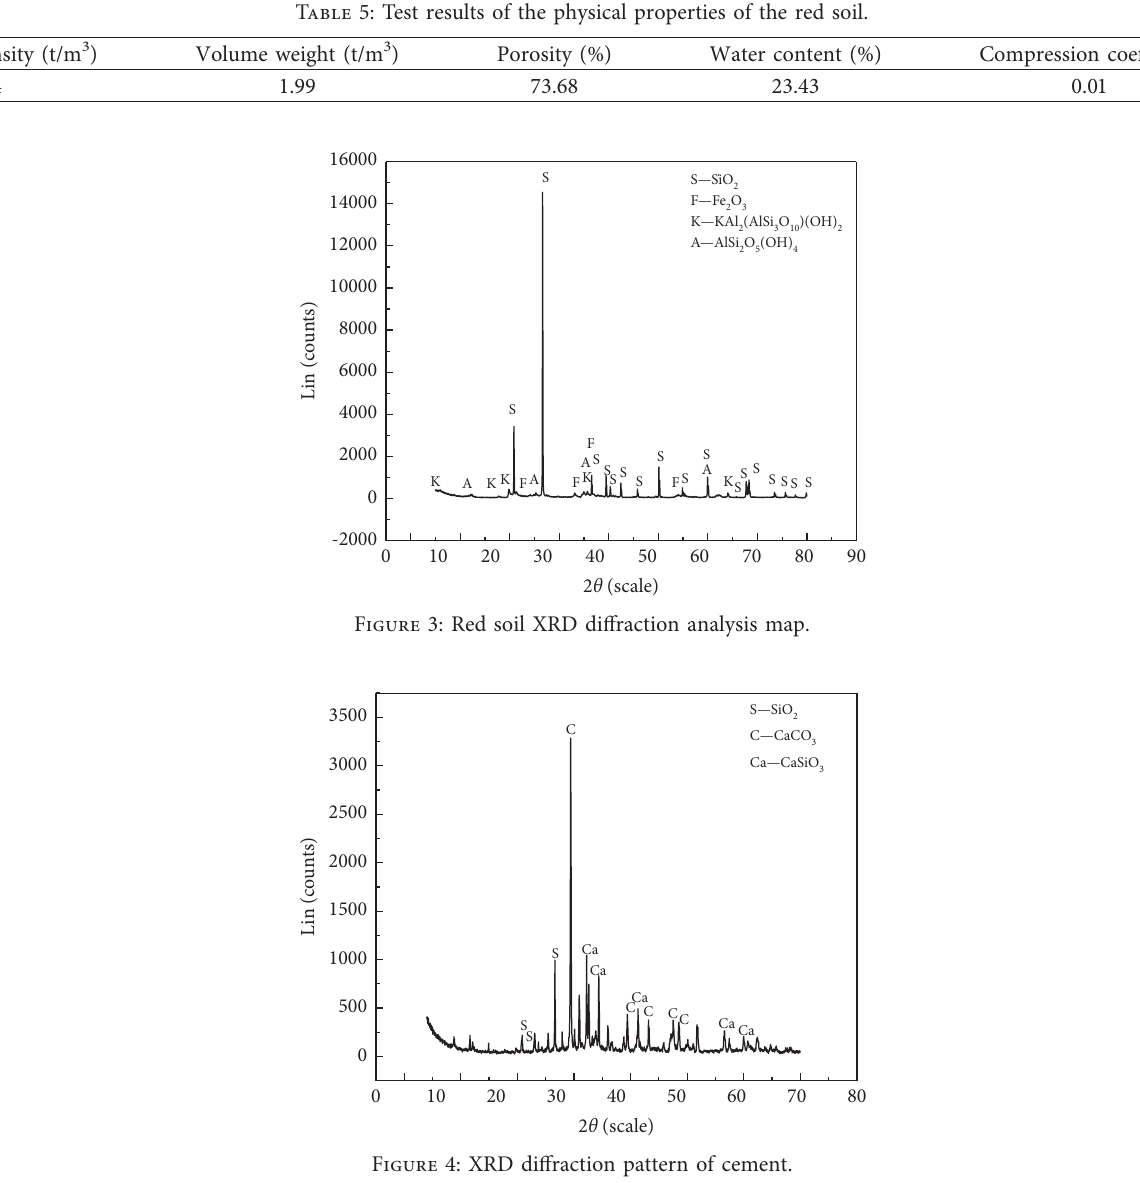
Table 5: Test results of the physical properties of the red soil.